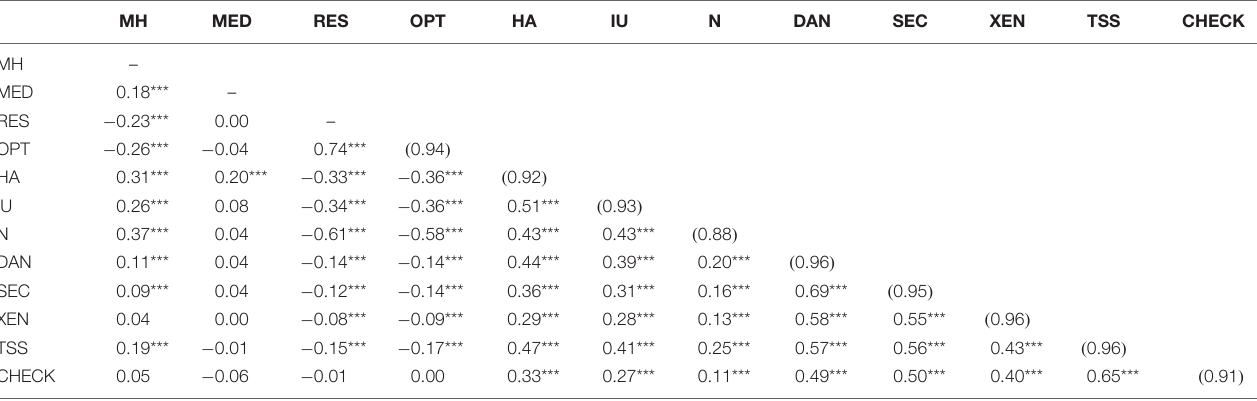
TABLE 1 | Correlations among variables (nodes) in the network analysis. Reliabilities ( ω ) for multi-item scales are in parentheses. MH MED RES OPT HA IU